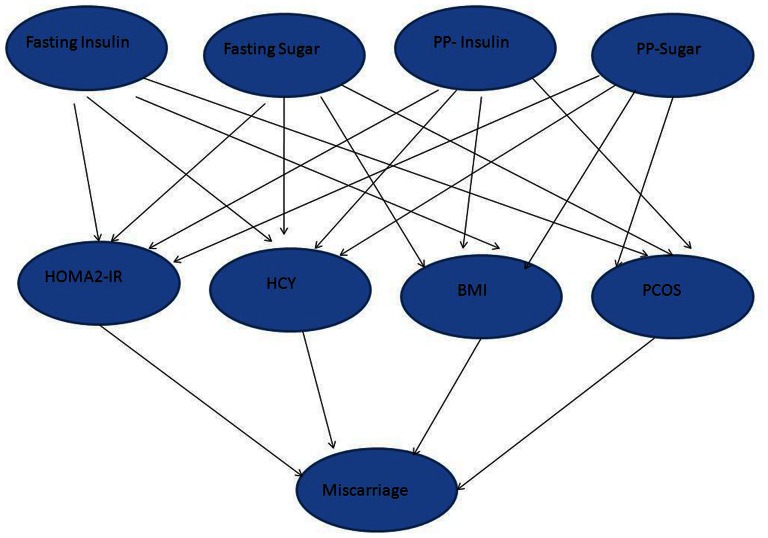
The structure of the model.